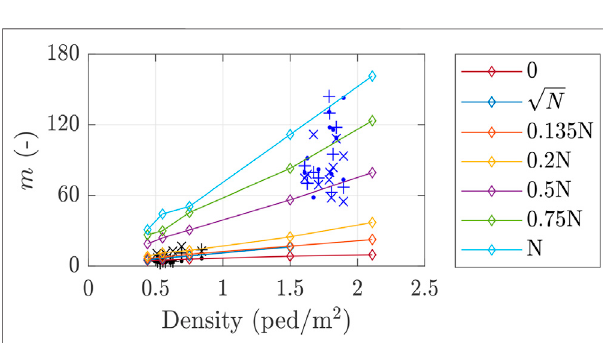
FIGURE 12 | Multiplication factors m obtained from 100 pedestrians (black markers) and 350 pedestrians (blue markers) for footbridge natural frequenciesof1.94 Hz(.),2.0 Hz(+) and2.1 Hz( × ).Colored lines:multiplication factors of Caprani et al. (2012) for different synchronization proportions.